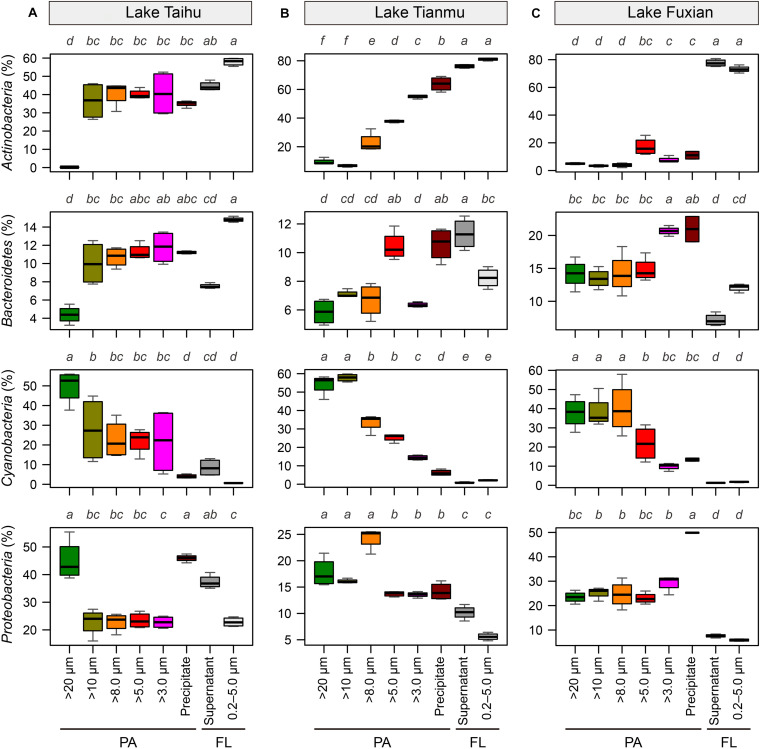
Boxplots of the major four bacterial phyla for each sample collection treatment in (A) Lake Taihu, (B) Lake Tianmu, and (C) Lake Fuxian. Note variation in y-axis scales in different lakes. To examine the differences between treatments, the Kruskal–Wallis test was performed with Holm correction of P-values for multiple comparisons. Different lower-case letters above each boxplot indicate significant differences (P < 0.05) among treatments. PA, particle-attached; FL, free-living.